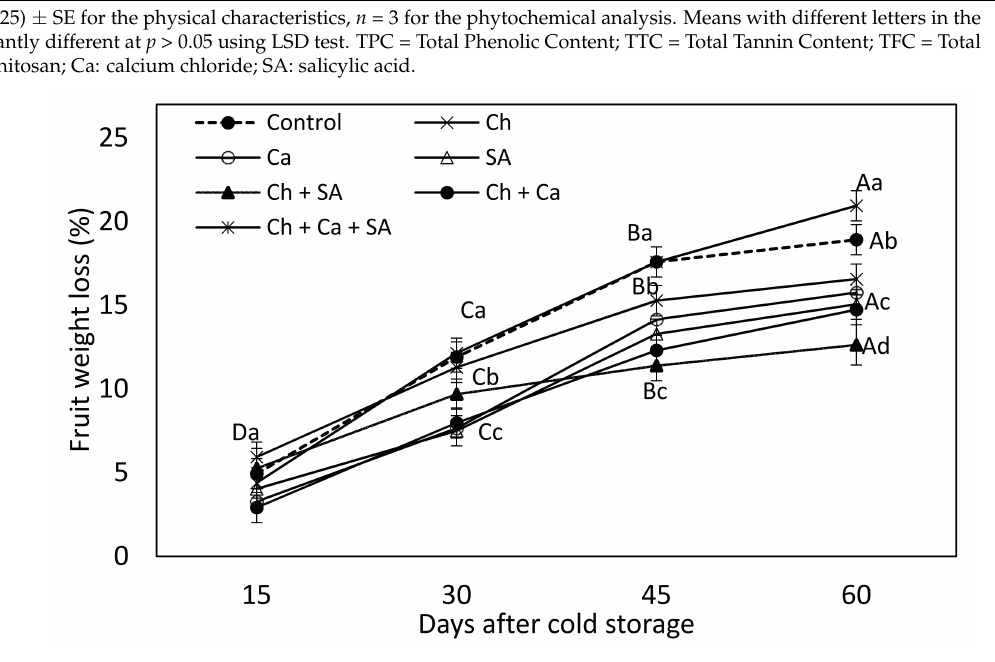
Figure 1. Effect of different preharvest treatments on weight loss of ‘Khesab’ fruit during cold storage, values are the mean ( n = 25) ± SE. Means with different letters between treatments (small letter) at different time interval (capital letter) are significantly different at p < 0.05 using LSD test.